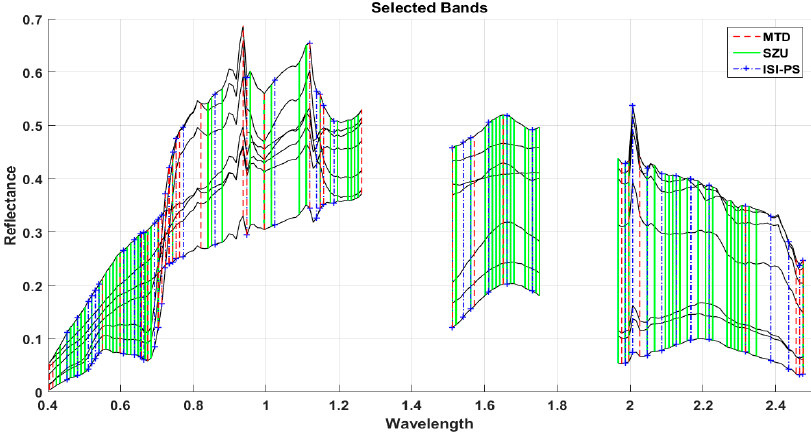
Figure 14. Representation of the selected bands using the MTD, SZU, and the proposed ISI-PS methods.